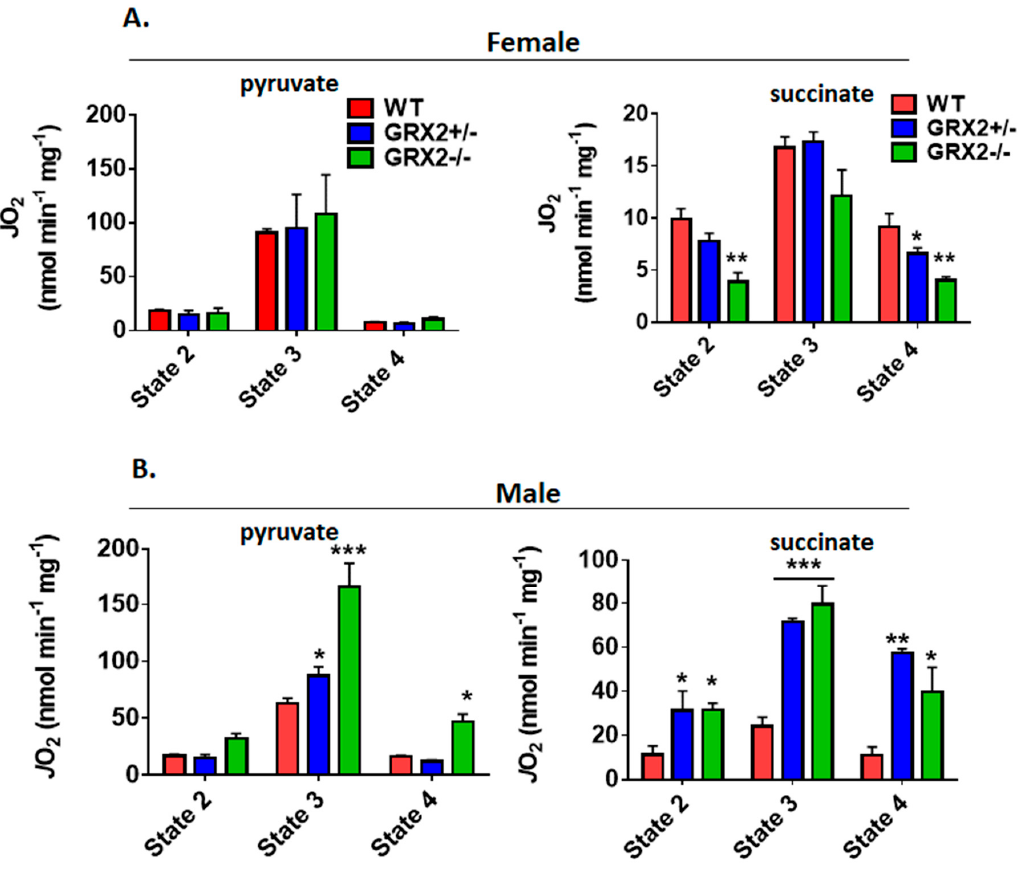
Figure 6. Polarographic measurement of the rate of O 2 consumption by muscle mitochondria isolated from female and male GRX2-deficient mice and WT littermates. ( A ). Assessment of the three respiratory states of female mitochondria oxidizing pyruvate (10 mM) and malate (2 mM) or succinate (5 mM). ( B ). Assessment of the three respiratory states of male mitochondria oxidizing pyruvate (10 mM) and malate (2 mM) or succinate (5 mM). n = 4, mean ± SEM, 1-way ANOVA with a post-hoc Tukey’s test. *: p ≤ 0.05, **: p ≤ 0.01, ***: p ≤ 0.001